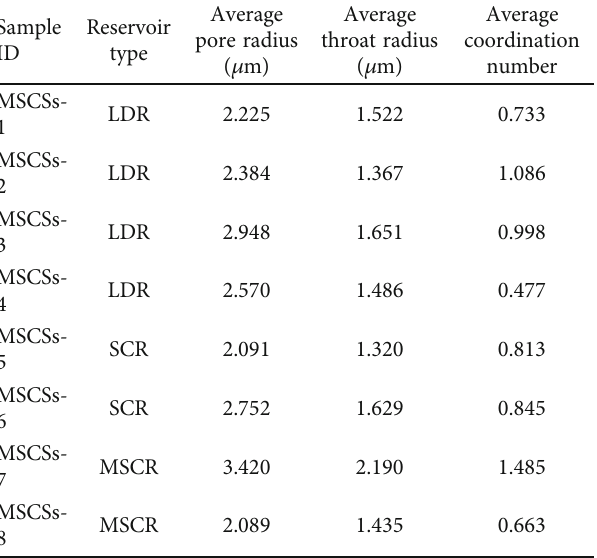
Table 2: Pore structure parameters of the Palaeogene Xiaganchaigou Formation samples measured by 3D micro-CT